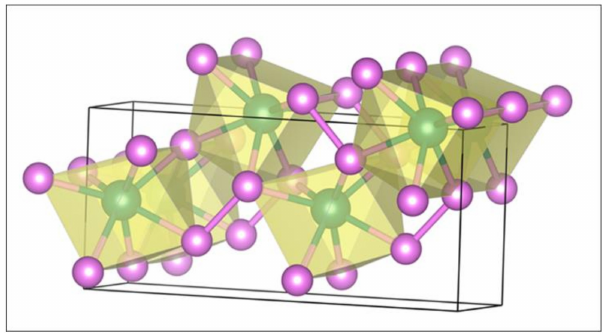
Figure 1. Bulk MoP 2 . Mo: dark green; P: